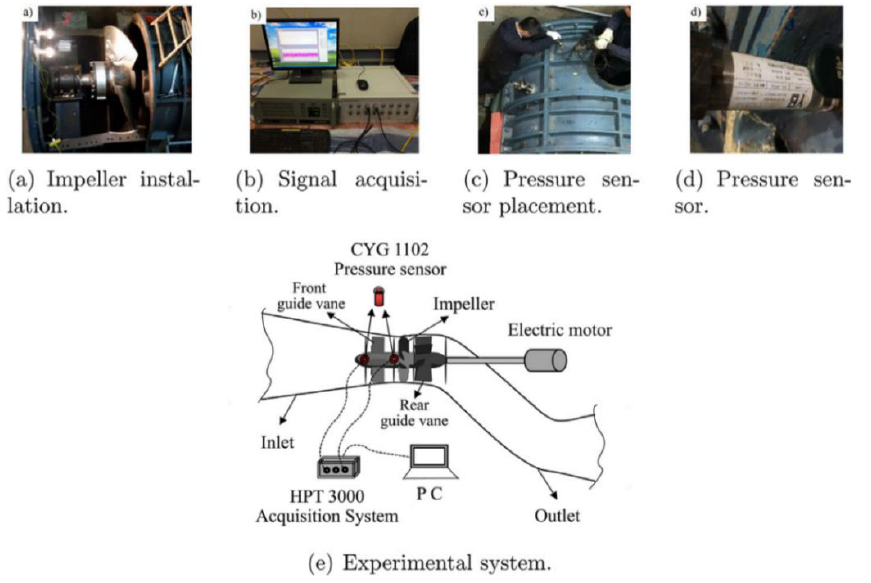
Figure 11. Field test of Chinese pump station [69]; ( a ) Impeller installation; ( b ) Signal acquisition; ( c ) Pressure sensor placement; ( d ) Pressure sensor; ( e ) Experimental system.